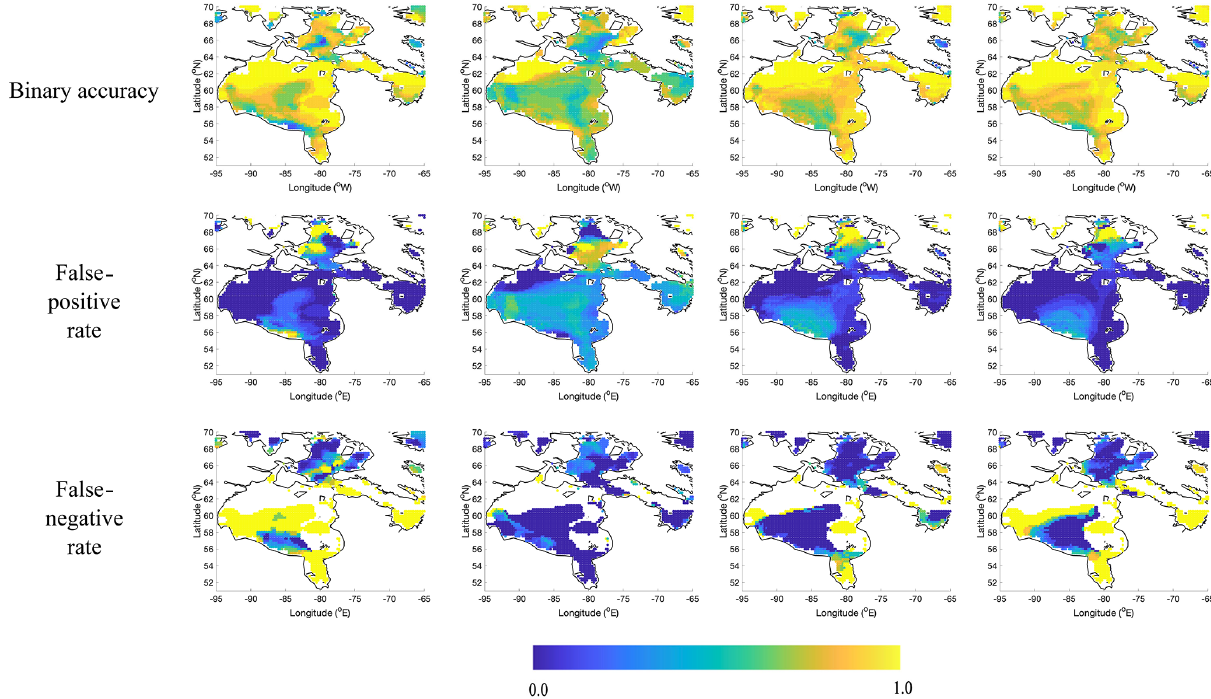
Figure 14. The columns from left to right are as follows: Climate Normal, S2S, Basic model, and Augmented model. Binary accuracy, false-positive rate, and false-negative rate calculated using data from forecasts launched between 1–30 June 2016 and 1–30 June 2017 at 30 lead days. These correspond to conditions from 1–30 July 2016 and 1–30 July